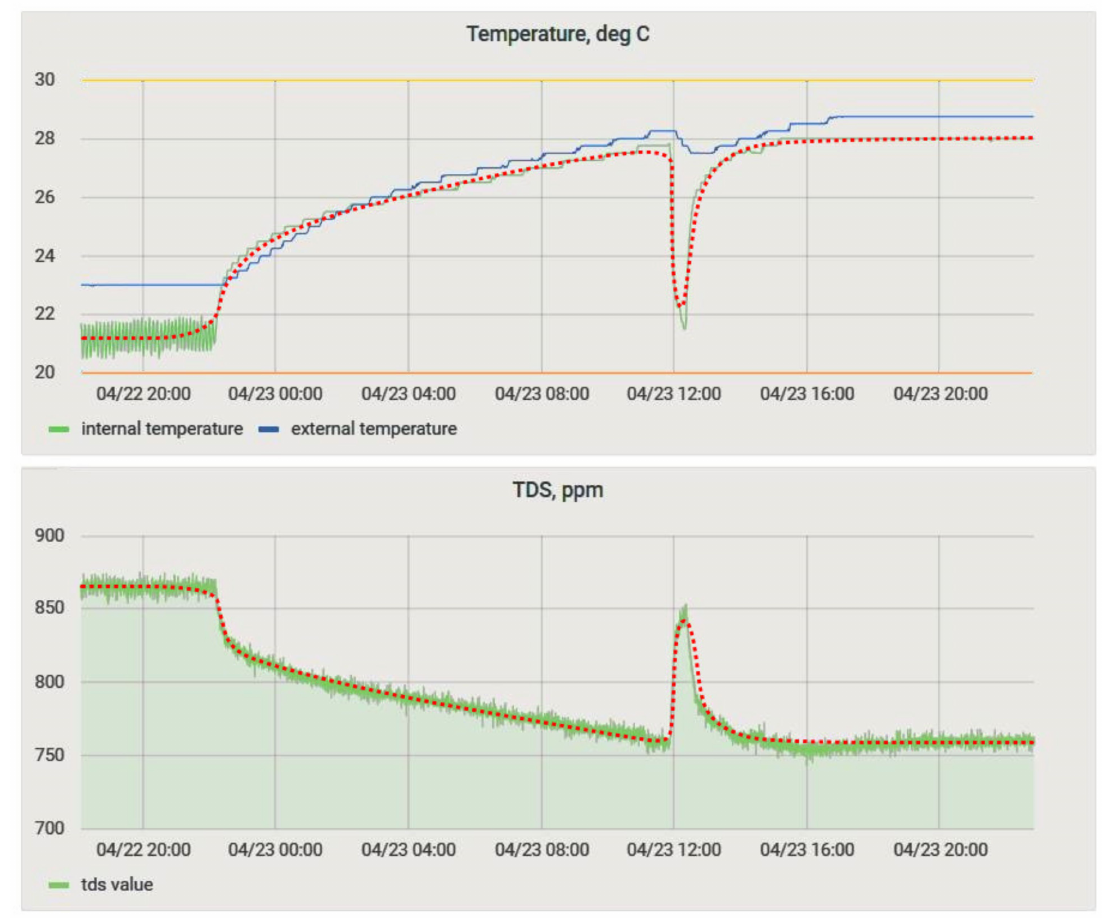
Figure 15. Sensor readings in the monitoring